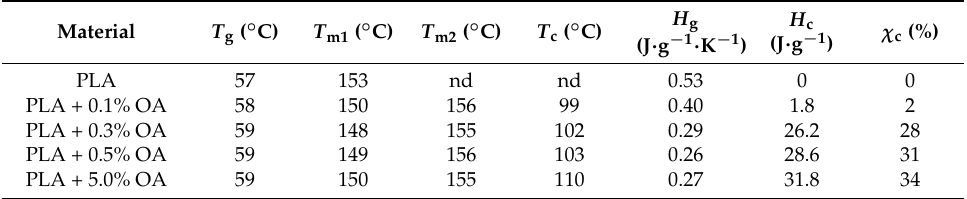
Table 1. DSC-derived parameters for PLA with the OA content.